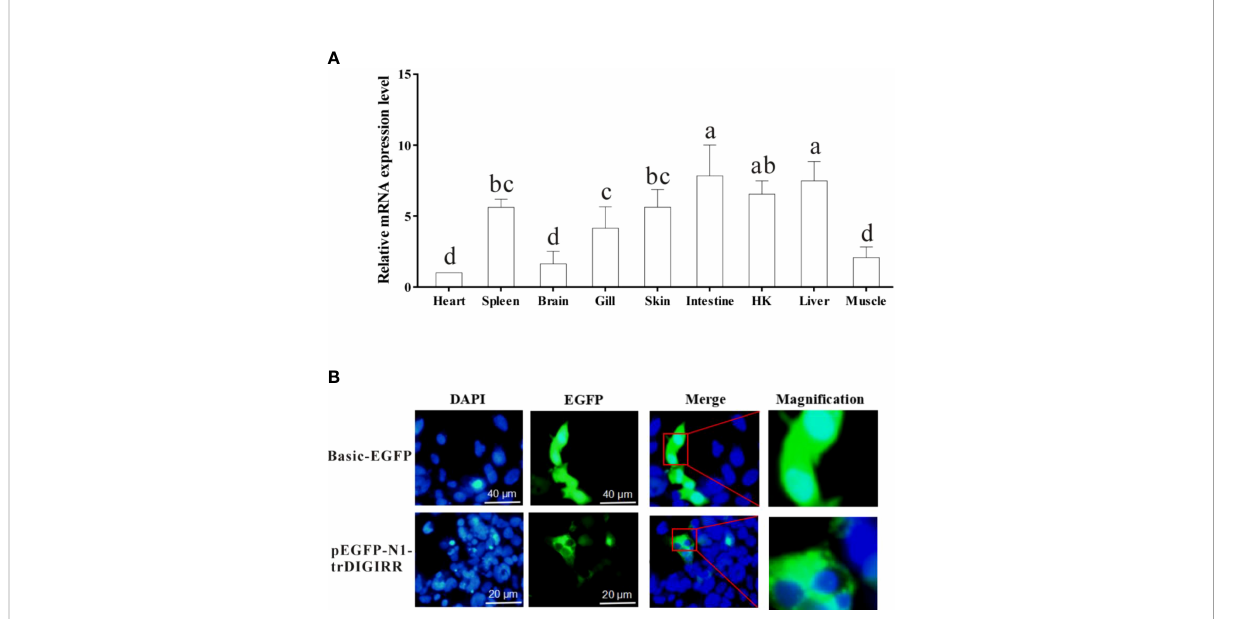
FIGURE 4 Relative mRNA expression level of DIGIRR in spleen, HK, skin, muscle, gill, heart, liver, brain and intestine of healthy golden pompano (A) , and the subcellular localization of trDIGIRR in HEK-293T cells (B) . A: Bars that do not share a letter represent a signi fi cant difference ( p <